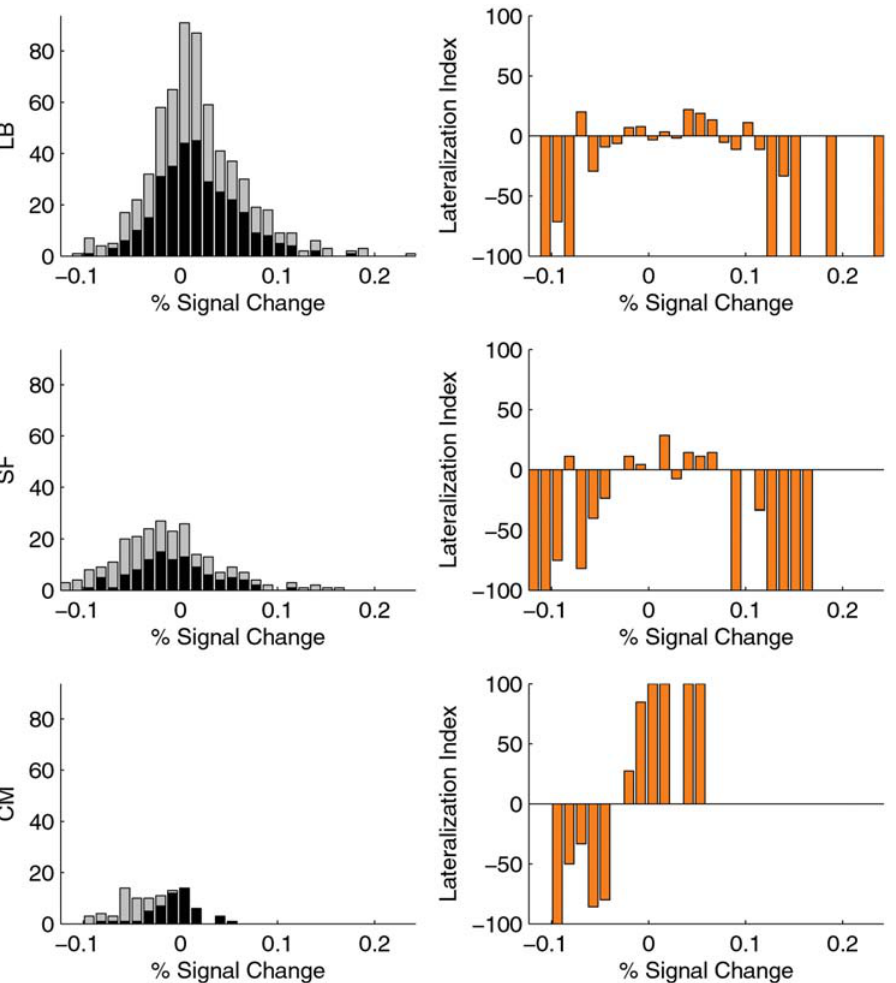
Figure 5. Lateralization patterns in the major subdivisions of the human amygdala. Histograms on the left show the distribution of BOLD percentage signal change (PSC) for voxels in: LB=laterobasal group, SF=superficial group, and CM=centromedial group. Values for the right (black) and left (light grey) amygdala are shown in a stacked way. For each PSC bin, a lateralization index (LI) was calculated. LIs of 100, 2 100, and 0 indicate purely right-sided, purely left-sided, and symmetrically distributed effects, respectively. LB and SF showed a similar lateralization pattern of both extremely positive and negative PSC predominating in the left amygdala. CM showed a different lateralization pattern with negative PSC predominating in the left and positive PSC in the right